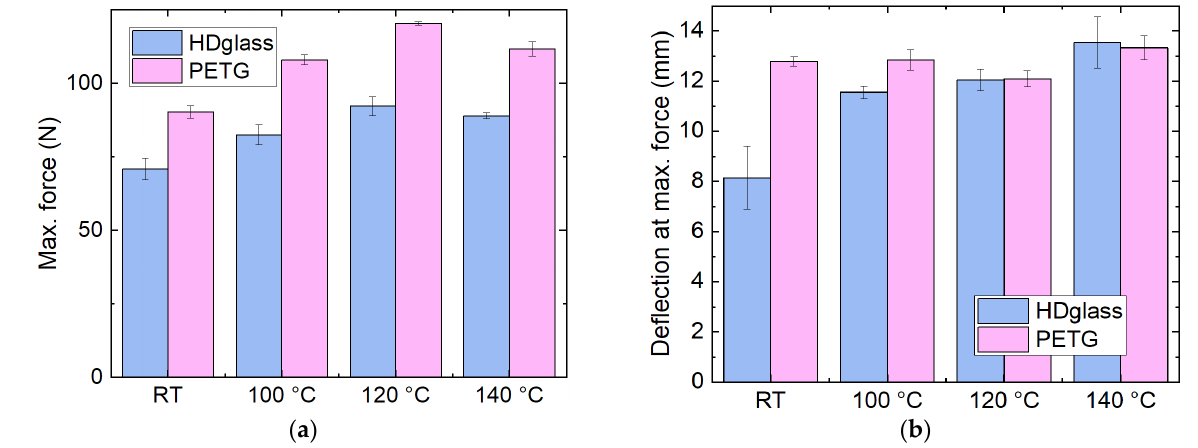
Figure 7. Mechanical properties of HDglass samples, as printed (RT) and heat-treated at different temperatures: ( a ) maximum force; ( b ) deflection at maximum force in 3-point bending